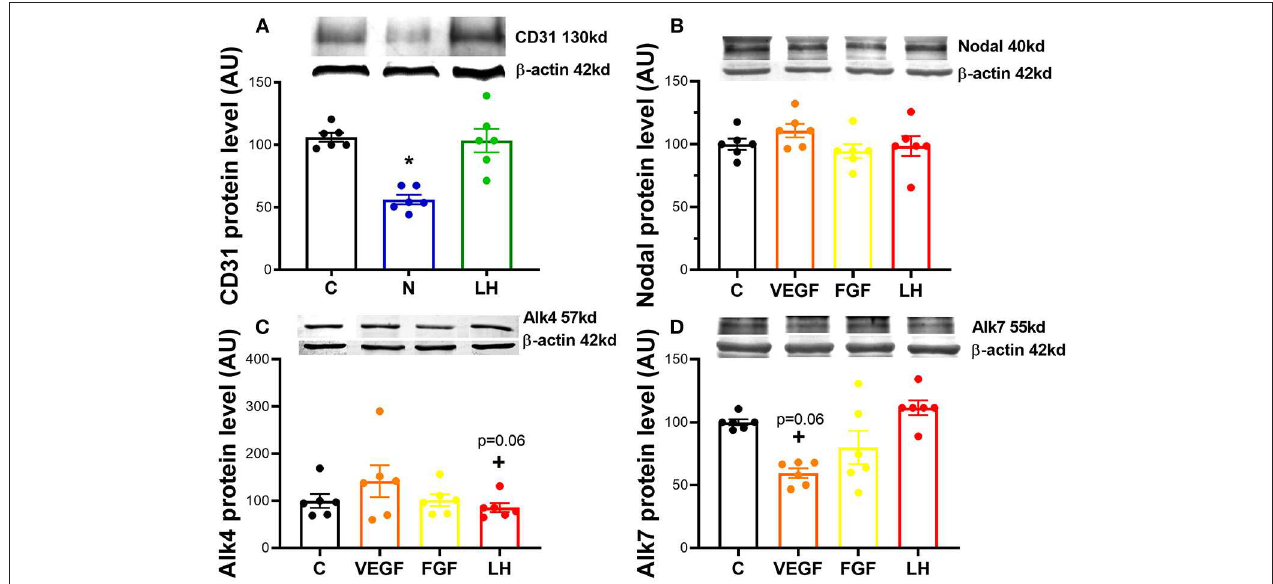
FIGURE 1 | Nodal interaction with proangiogenic factors. (A) Expression of proangiogenic cluster of differentiation 31 (CD31) protein after 24h culture: (i) no factor (C, negative control); (ii) Nodal (10ng/mL); and (iii) luteinizing hormone (LH, 10ng/mL). Expression of angiogenic factors on (B) Nodal, (C) activin receptor (Alk) type 1B (Alk4) and (D) type 1C (Alk7) after 24h culture with: (i) C (negative control); (ii) vascular endothelial growth factor A (VEGFA, 25ng/mL); (iii) fibroblast growth factor (FGF, 10ng/mL); (iv) luteinizing hormone (LH, 10ng/mL). Protein expression determined by western blot, upper panel: representative immunoblot; lower panel: densitometry of protein expression relative to β -actin expression. ( n = 6). Values are expressed as means ± SEM in arbitrary units (AU). Statistical differences marked with an asterisk (* p < 0.05).